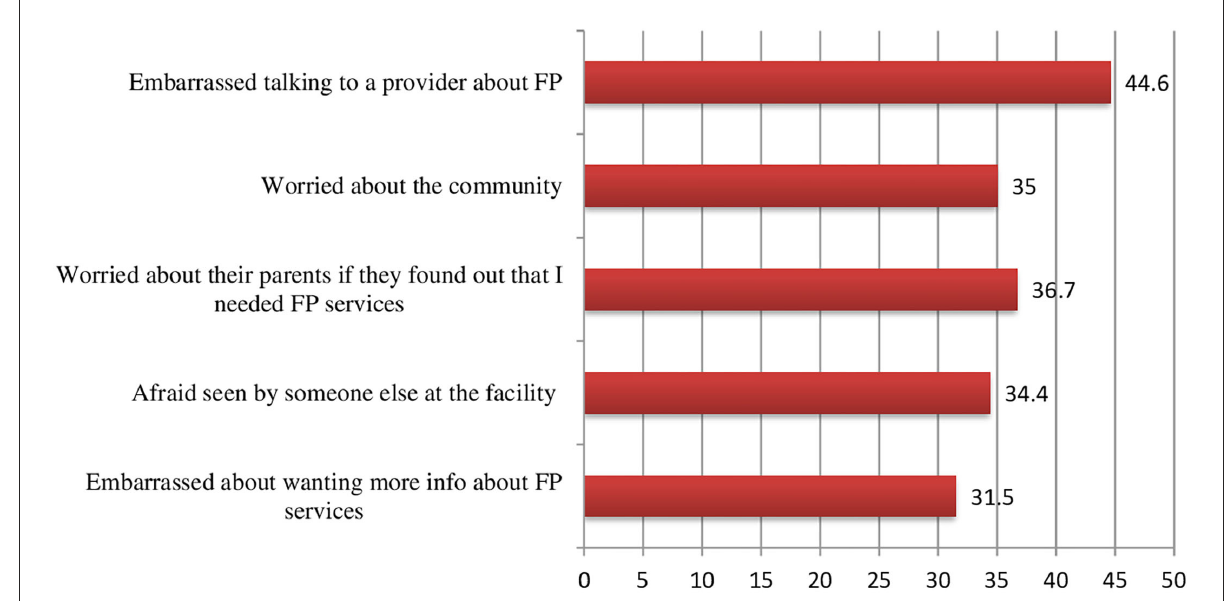
FIGURE2 Agreement with perceived internalized stigma statements by 15–24-year-old young married